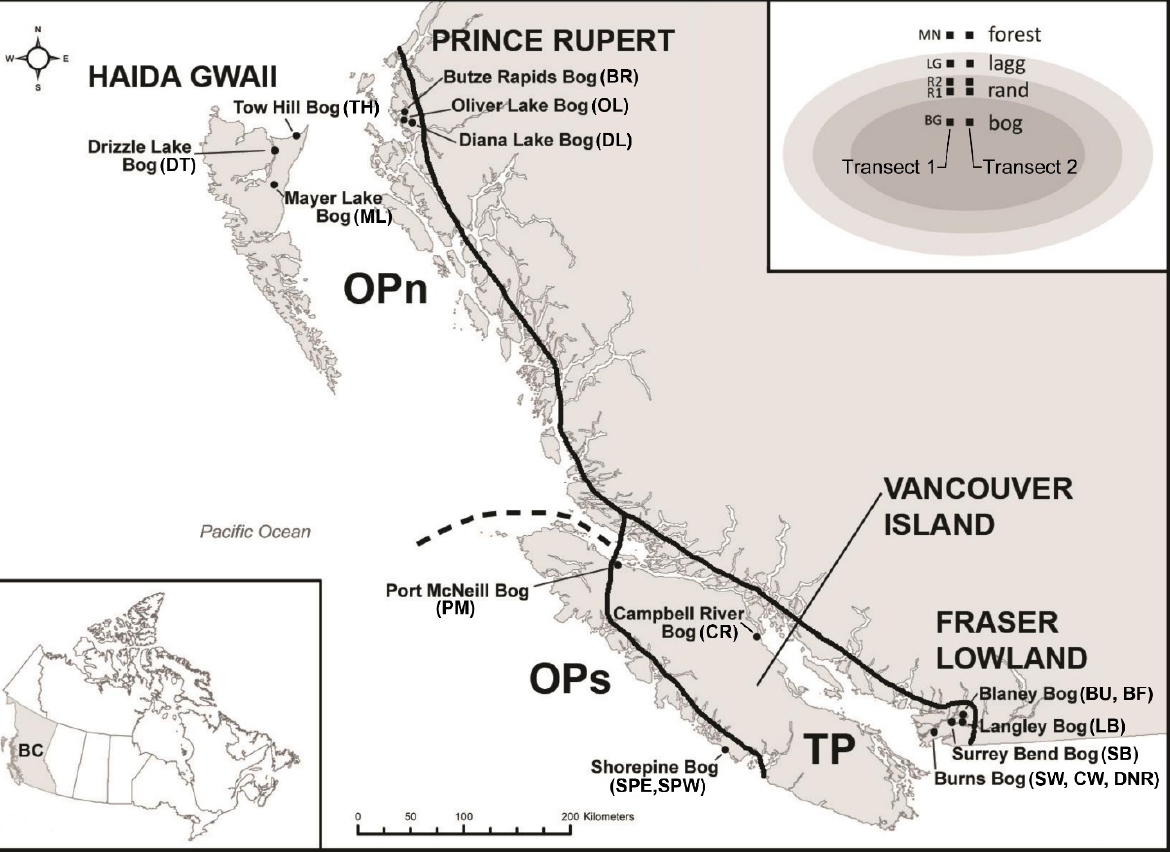
Figure 1. Locations of the research sites (black dots) and study regions in coastal British Columbia (BC). The thick black lines define the two coastal wetland regions and subregions: OPn = Pacific Oceanic, North Coast wetland subregion; OPs = Pacific Oceanic, South Coast wetland subregion; and TP = Pacific Temperate wetland region. Wetland region boundaries are from NWWG (1988). Lower inset: map of Canada; upper inset: generic study transect diagram, where closed symbols represent individual study plots on the transects. BG = bog, R1 and R2 = rand, LG = lagg, MN = minerotrophic ecosystem adjacent to